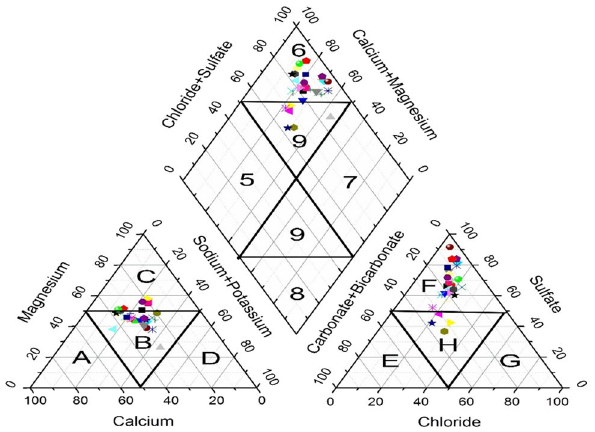
Fig. 9 Piper plot of water samples for monsoon season. The piper diagram can be separated in hydrogeochemical facies. Legend: A: Calcium type; B: No dominant type; C: Magnesium Type; D: Sodium and Potassium type; E: Bicarbonate type; F: Sulfate type; G: Chlo- ride type; H: No dominant type; 1: Alkaline earths exceed alkalis; 2: Alkalies exceed Alkaline earths; 3: Week acids exceed strong acids; 4: Strong acids exceed week acids; 5: Magnesium Bicarbonate type;